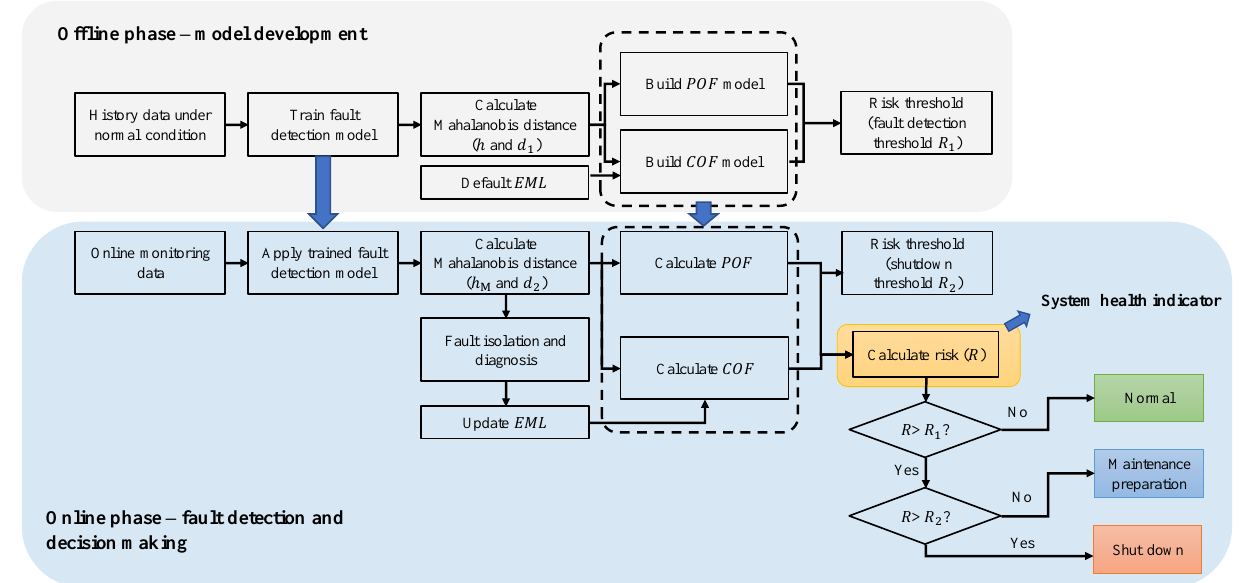
Figure 1. Flow chart of the proposed methodology to calculate integrated system health indicator (estimated maximum loss ( EML ), description presented in Section 2.1.3; h is system wide feature in the offline phase; h M is system wide feature in the online phase; d 1 is the fault detection threshold in Mahalanobis distance; d 2 is the shutdown threshold in Mahalanobis distance; R 1 is the fault detection threshold for the system health indicator ( R ); R 2 is the shutdown threshold for the system health indicator.)